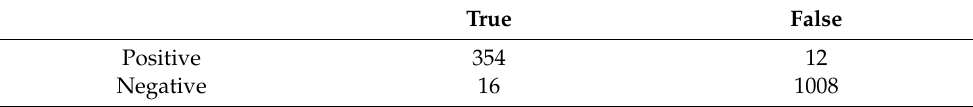
Table 4. Confusion matrix of SVM classifier applied five days before the swarming event. True False Positive 354 12 Negative 16 1008